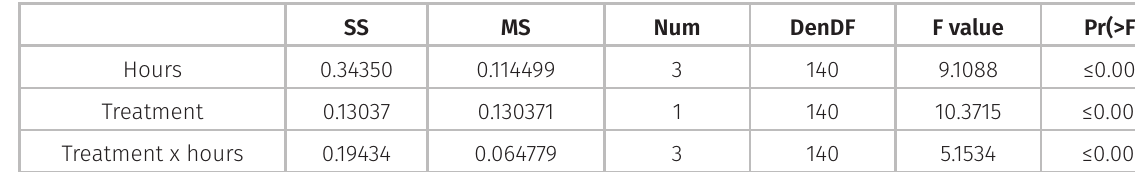
Table II. Significance of the fixed effects of the best generalized mixed model of the phytohemagglutinin skin swelling-assay over time (prior injections and 2h, 20h, and 48h post-injection) between treatments (PHA and PBS) for adult males of Liolaemus kingii .